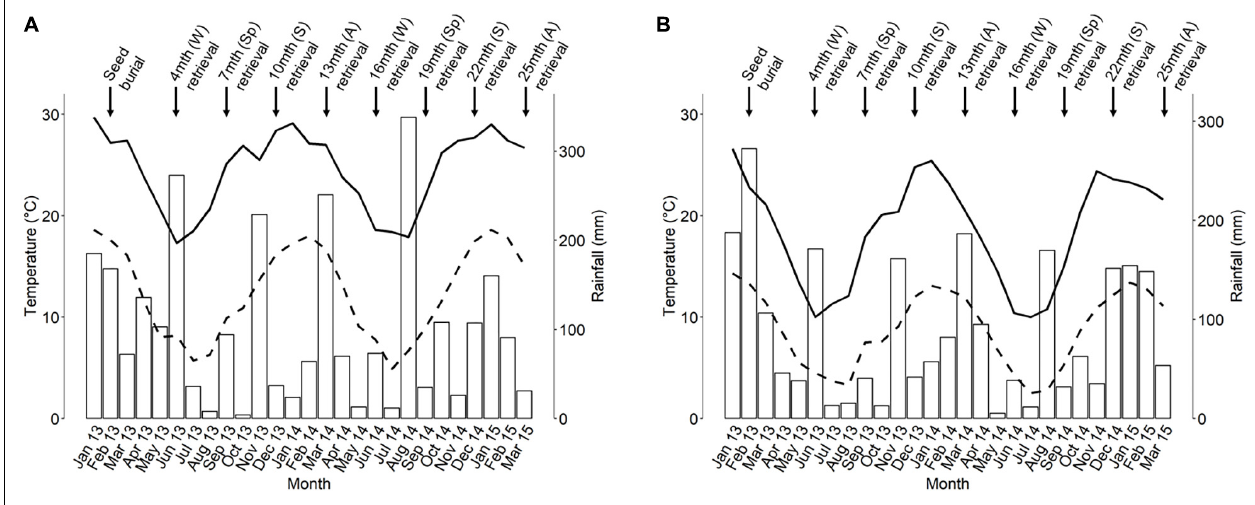
FIGURE 2 | Indicative monthly rainfall (white bars) and mean monthly maximum (solid line) and minimum (dashed line) ambient temperature at the (A) coastal and (B) upper tablelands study sites during the study period. Data are courtesy of the Australian Government Bureau of Meteorology (2021). Temperature and rainfall data in (A) are from the Holsworthy Aerodrome and Audley Royal National Park weather stations, respectively. All data in (B) are from the Mt Boyce weather station. S, summer; A, autumn; W, winter; Sp, spring.